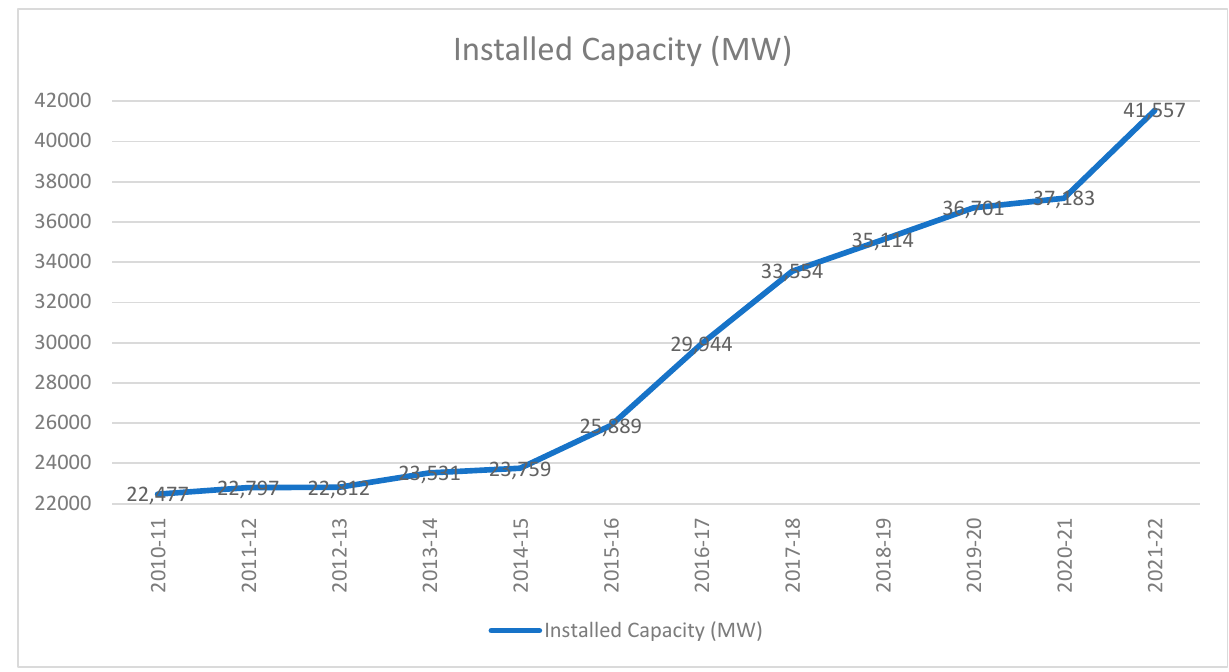
Figure 1. Installed capacity of Pakistan’s electricity power sector in megawatts (2010 to 2022).